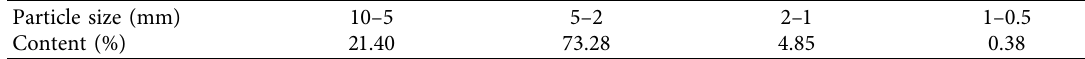
Table 1: Particle size distribution of continuously graded aggregates.